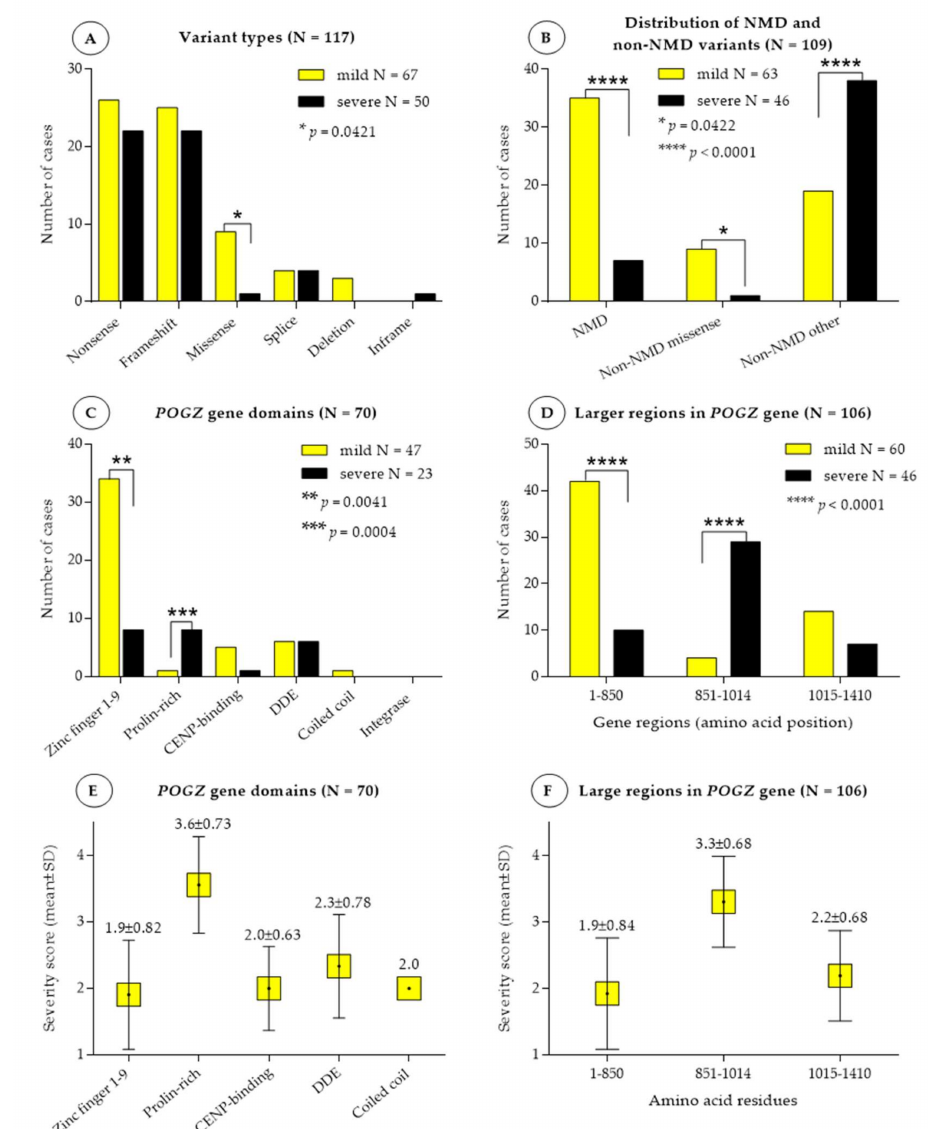
Figure 2. Distribution of all POGZ -variants in patients with mild and severe phenotypes. NMD: Nonsense-mediated RNA decay; CENP-binding: Centromere protein (CENP)-B-DNA-binding do- main; DDE: originated from a transposase encoded by a pogo-like DNA transposon. Mild phenotype: patients with severity score 1 and 2, severe phenotype: severity score 3 and 4. ( A ): Distribution of the variant types in comparison to the severity of the phenotypes. Missense variants are